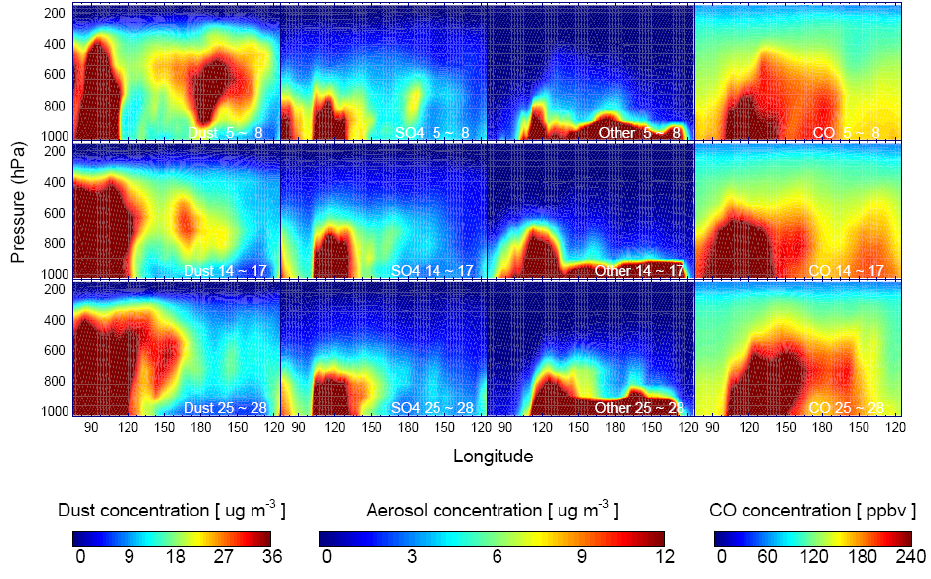
Fig. 5. Cross sections of simulated mixing ratio of dust (first column), sulfate (second column), and the rest of aerosols (third column), and simulated CO mixing ratio during 5–8 (first row), 14–17 (second row), and 25–28 (third row) May 2003 across the Pacific, averaged over 40–60 ◦ N as a function of longitude and